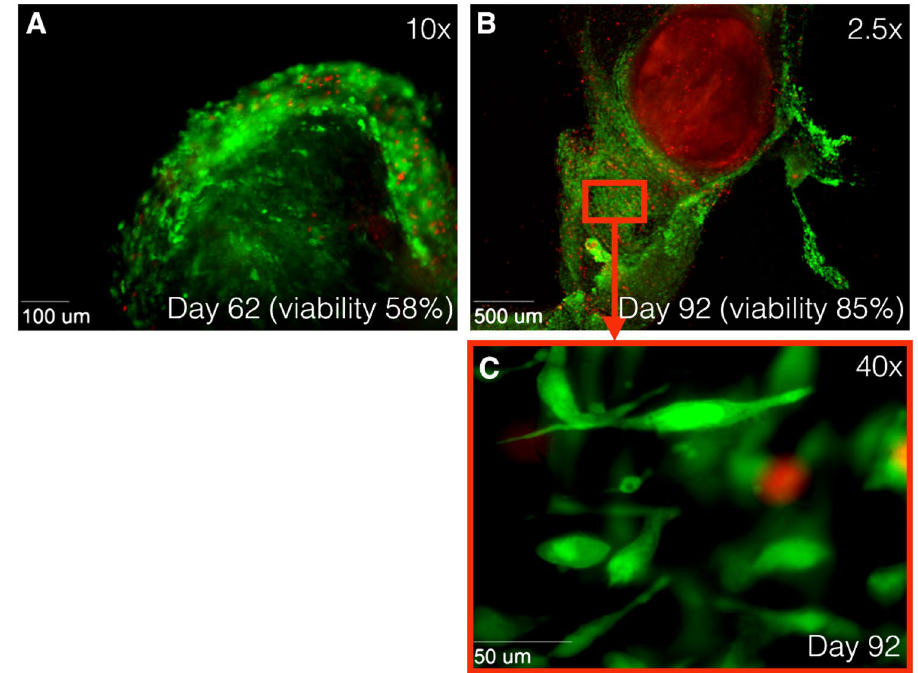
Figure 3. Immunofluorescence images at 10 × magnification using Zeiss Axiovert 200 M Marianas ™ Microscope. Human tissue stained with LIVE/DEAD ® Viability/Cytotoxicity Kit. Green fluorescence shows live cells, while red fluorescence indicates dead nuclei. ( A) Alive tissue at day 62 after harvesting. Tissue viability of 58%. ( B) Alive tissue at day 62 after harvesting at 2.5 × magnification and ( C ) at 40 × magnification. Outgrowth of new cells is observed after 92 days, while original tissue shows only staining of EthD-1 (dead cells). Tissue viability of 85%. EthD-1 indicates ethdium